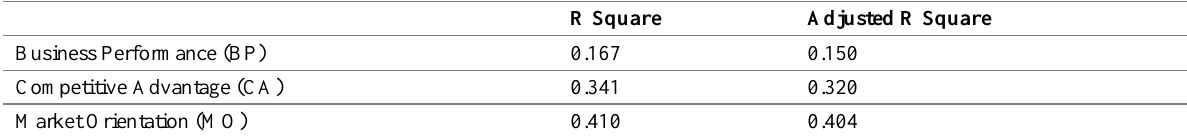
Table 2: Value of R